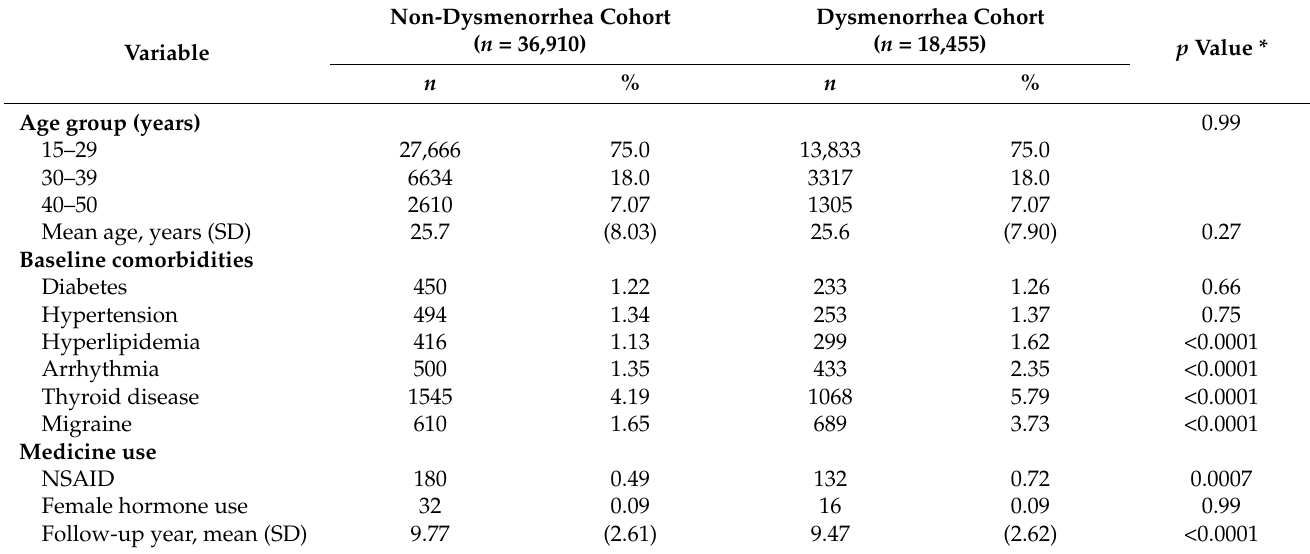
Table 1. Characteristics compared between women with and without primary